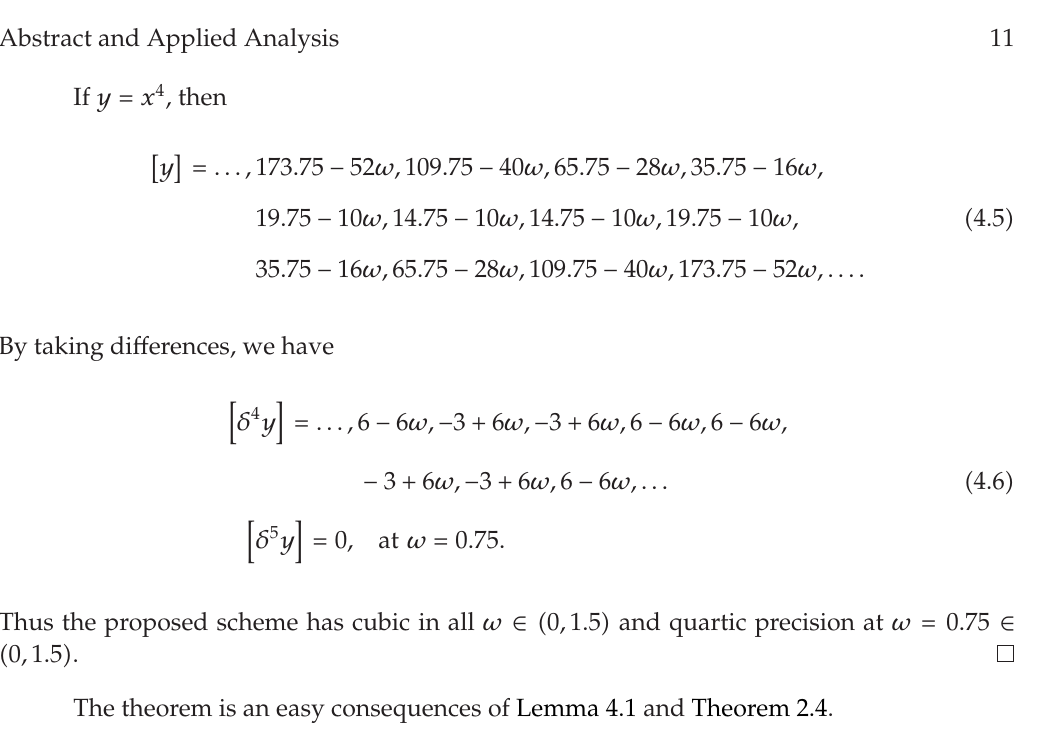
Figure 2 (cid:2) a (cid:3) shows the basic limit function ψ (cid:8) S ∞ f 0 theorem is related to the support of limit